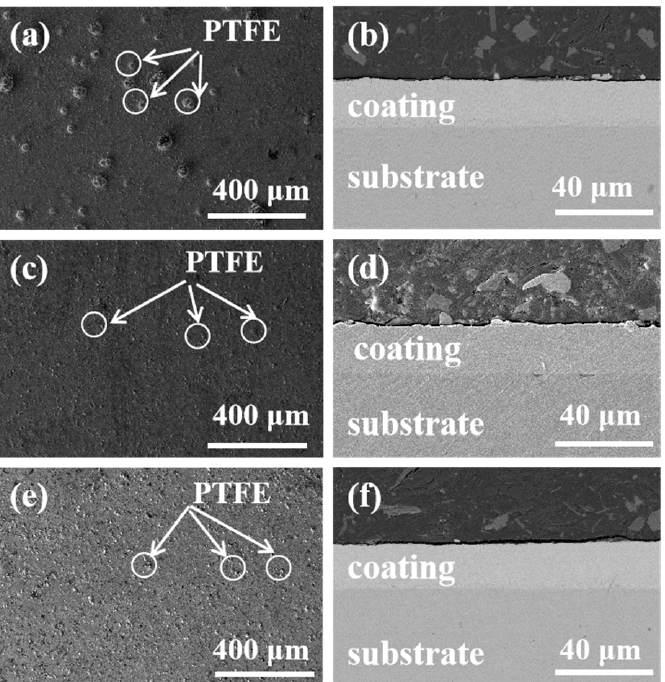
Figure 2. SEM images of surface and cross-section of Ni-Cu-P-PTFE composite coating: PTFE (10 mL/L) ( a , b ); PTFE (15 mL/L) ( c , d ); PTFE (20 mL/L) ( e , f ).